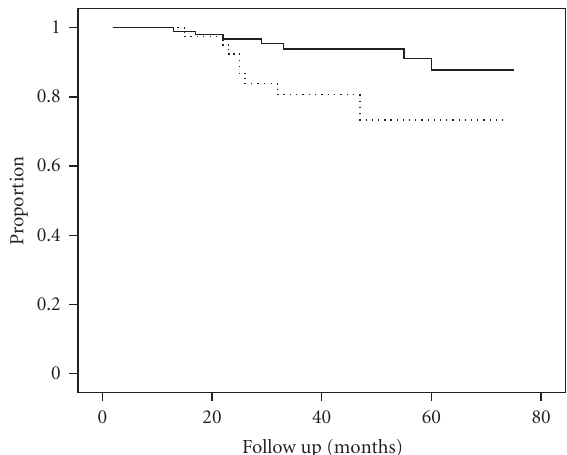
Figure 1: Actuarial probability curve of remaining free of recurrent symptomatic CBD stone after complete removal of the initial CBD stone with subsequent cholecystectomy. The patients with type 1 or 2 diverticulum versus those without diverticulum or those with type 3 diverticulum (80.5% versus 93.2%, resp.; P = 0 . 02, log-rank test) (---The patients with Type 1 or 2 diverticulum, or —the patients with type 3 diverticulum or without diverticulum).